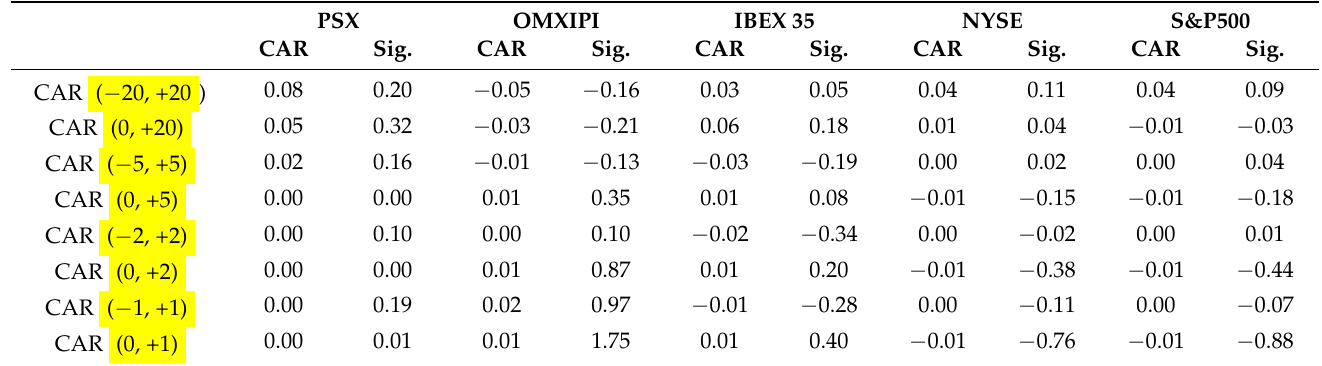
Table A29. Cumulative abnormal returns (Jurgen Mossack